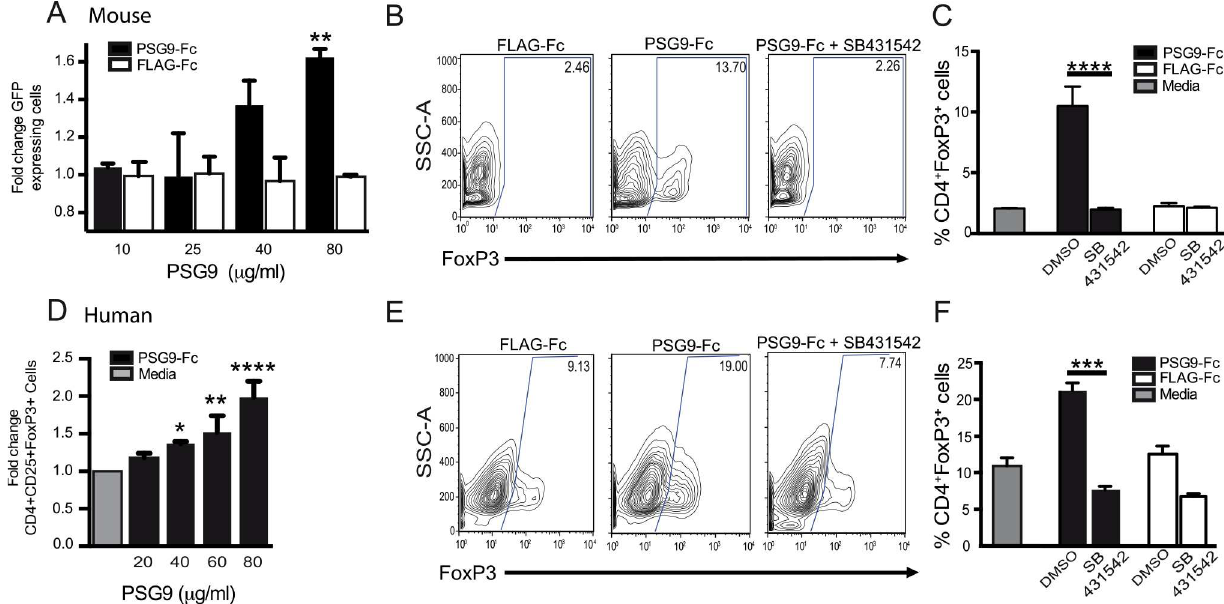
Fig 5. PSG9convertsmurine and human naiveCD4 + T-cellsinto FoxP3 + cellsin a TGF- β dependent manner. (A) T-cellsisolatedfrom the spleensof FoxP3-GFP transgenic micewerestimulated withT-cell activatorDynabeadsin thepresenceof IL-2 andincreasingconcentrationsof PSG9-Fc or FLAG-Fc controlandanalyzedat 72 h for GFP expression. P < 0.0005.(B) NaivemouseCD4 + T-cellsweretreatedwithPSG9-Fcor FLAG-Fc in thepresenceof SB-431542or vehicle(DMSO)andanalyzedas inA. (C) Graphical representationof the flowcytometrydatashownin part(B). P < 0.0001.D) CD4 + naiveT-cellsisolatedfrom peripheral bloodwerestimulated withhumanT-cellactivatorDynabeads inthe presence of IL-2andincreasingconcentrationsof PSG9-Fcor controlprotein.Analysiswasperformed 72h after activation. Cellpopulationsweregatedon viableCD4 + CD25 + cellsandwerestainedwithAPC-labeled anti-humanFoxP3antibody.P < 0.0001.(E) NaivehumanCD4 + T-cellsweretreated withPSG9-Fcor FLAG-Fc inthepresenceof SB-431542or DMSO, andanalyzedat 72 h by flowcytometry for FoxP3 expression. (F) Graphical representationof theflowcytometerdatashowninpart (E). P < 0.0005.Cellswereinitiallygatedonviability,followedby gatingonCD4andFoxP3 (human)or GFP expression (mouse). Thedata shownarerepresentative of at leastthreeindependent experiments performedin triplicate. P-values werecalculatedusingone-wayANOVA(B, D andE) andtwo-wayANOVA(A).